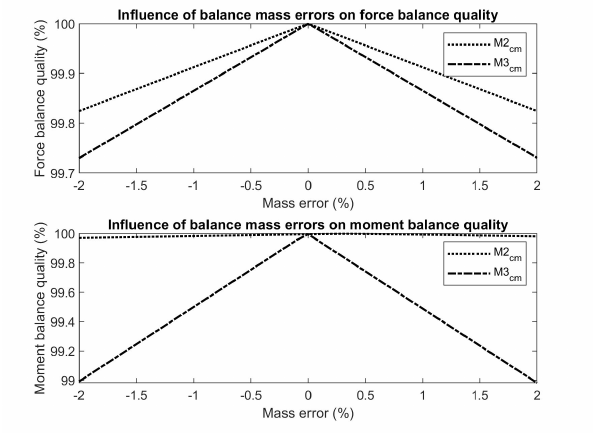
Figure 8. The influence of the mass errors in the balancing masses on the balance quality shows to be relatively small.